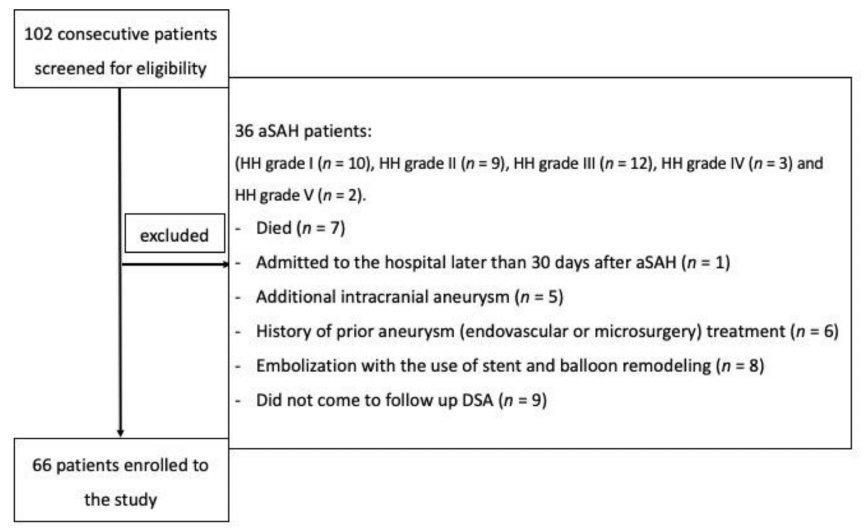
Figure 3. Flowchart presenting the enrollment of the